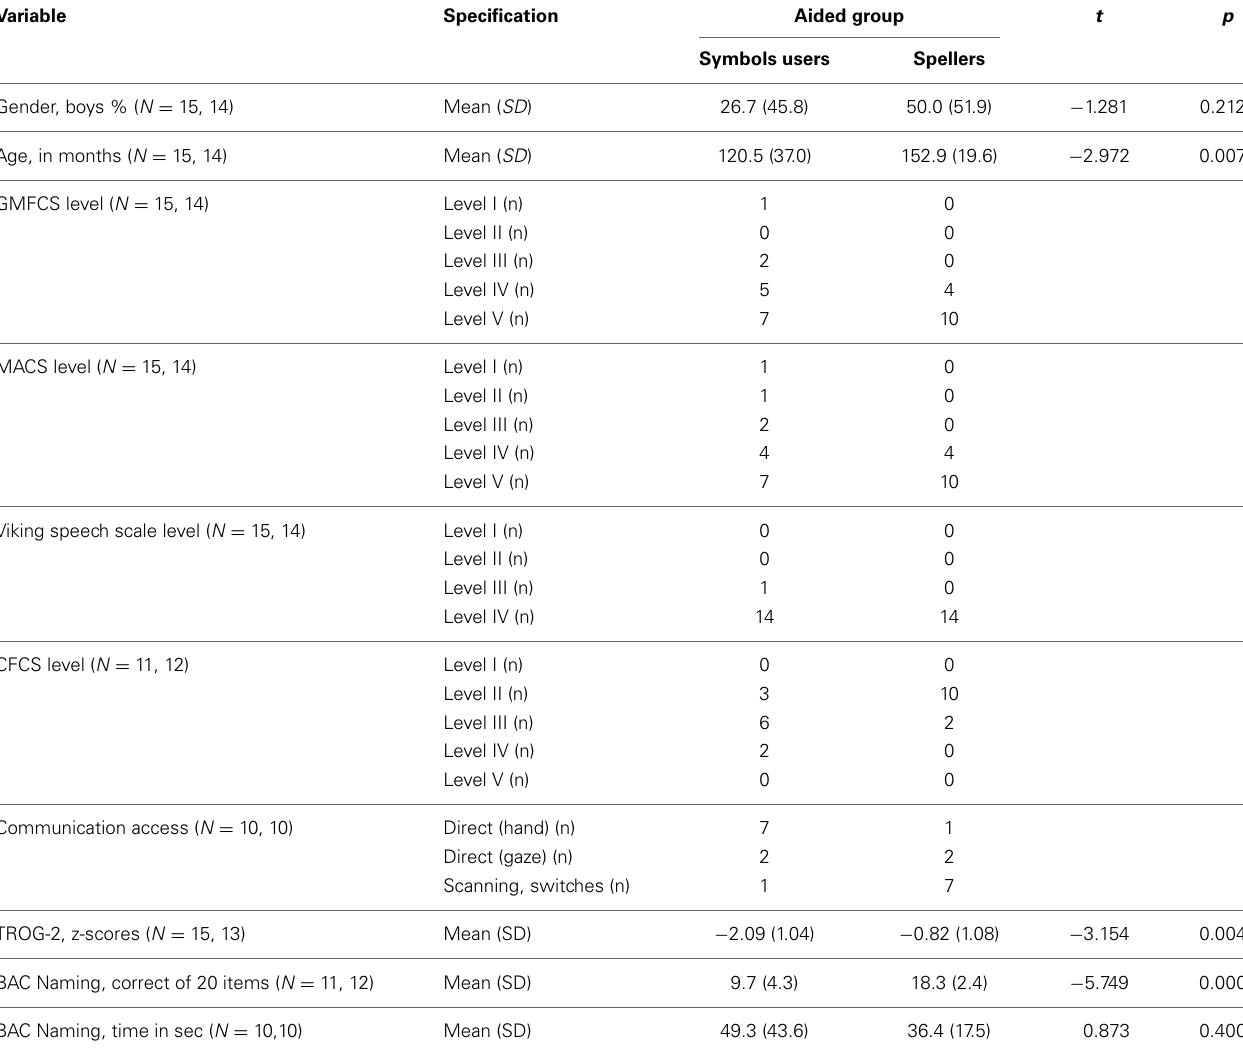
Table 2 | Characteristics of the aided communicators.